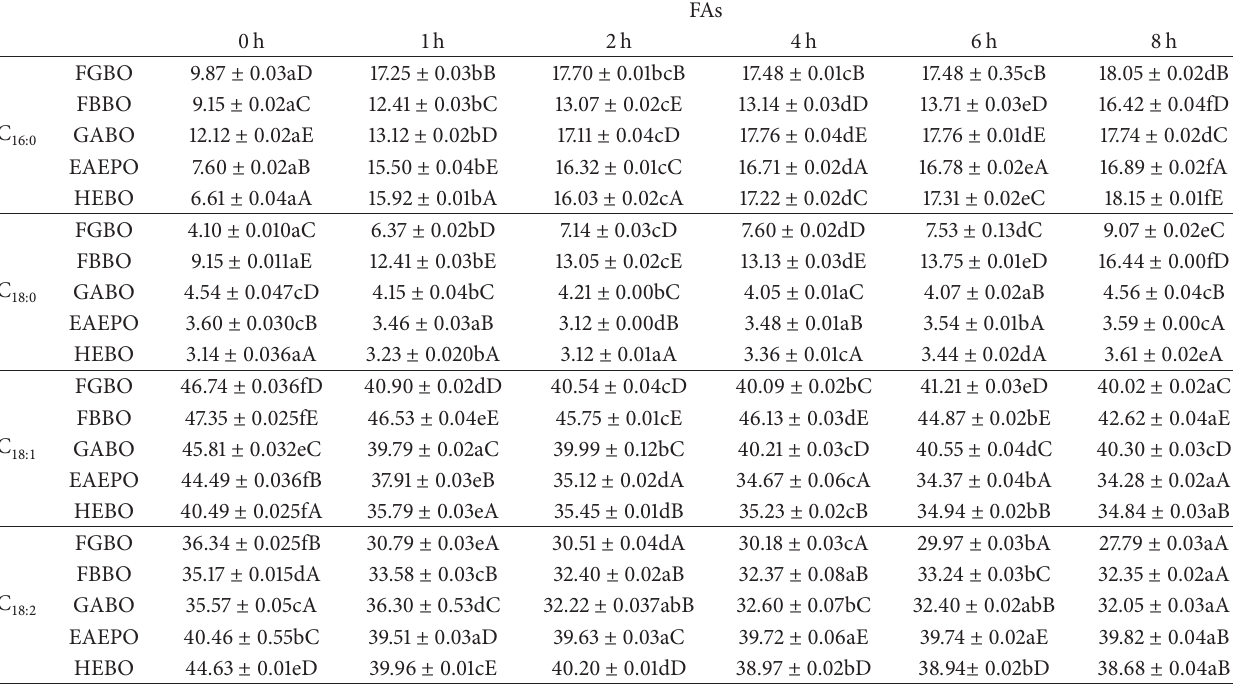
Table 3: Main fatty acids (%) profile.